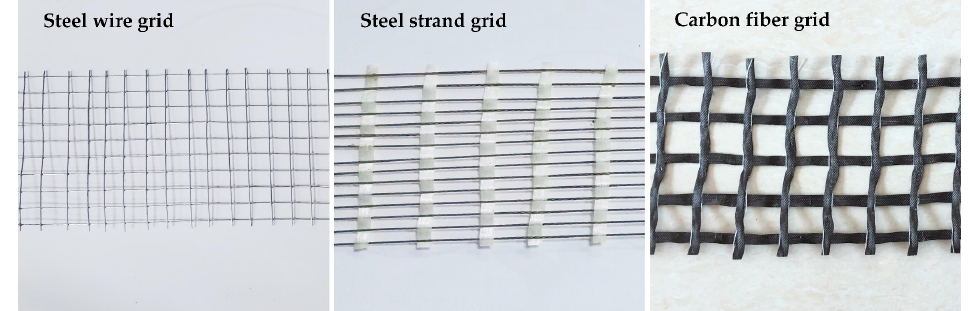
Table 3. Physical and mechanical properties of cement.